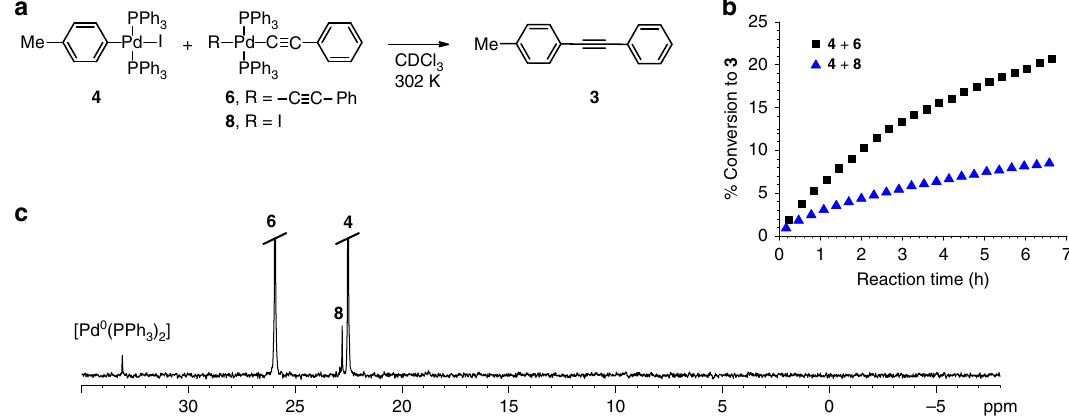
Fig. 4 Probing transmetallation. a Reaction between 4 (1.0 equiv., 0.013 M) and acetylide 8 or 6 (1.2 equiv., 0.016 M). b Tolan 3 build-up. c 31 P NMR analysis of the reaction mixture between 4 and 6 incubated for 90 min (Supplementary Note 3 and Supplementary Figs. 15 –